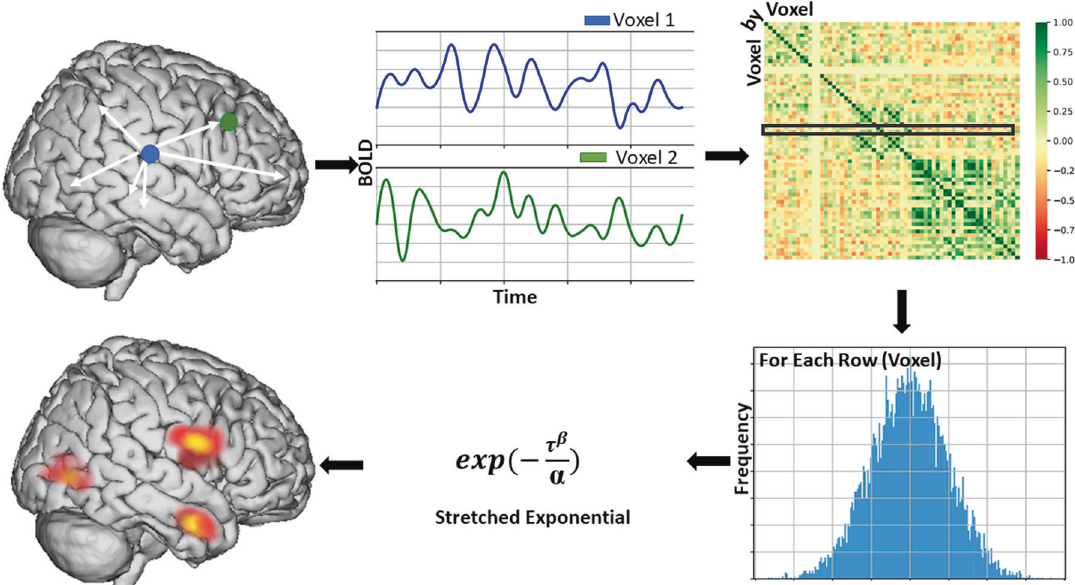
Fig. 1 Overview of the intrinsic connectivity distribution analysis method. Intrinsic Functional Connectivity of each voxel, as measured by the Intrinsic Connectivity Distribution (ICD), is calculated by correlating the time series for a grey matter voxel with every other voxel ’ s time course. This procedure is repeated for every voxel, resulting in a voxel-by-voxel correlation matrix. From this matrix, a single row is extracted, which represents all correlations to a voxel, and converted to a histogram to estimate the distribution of connectivity for that voxel. From this distribution, a survival function is constructed and fi tted with a stretch exponential with unknown parameters α and β . For our purposes, α controls the rate of decay of the survival function with a larger α indicating a slower decay and larger global connectivity. The α ICD maps can then be thresholded resulting in a whole-brain parametric image that reveals putative hubs of the individual